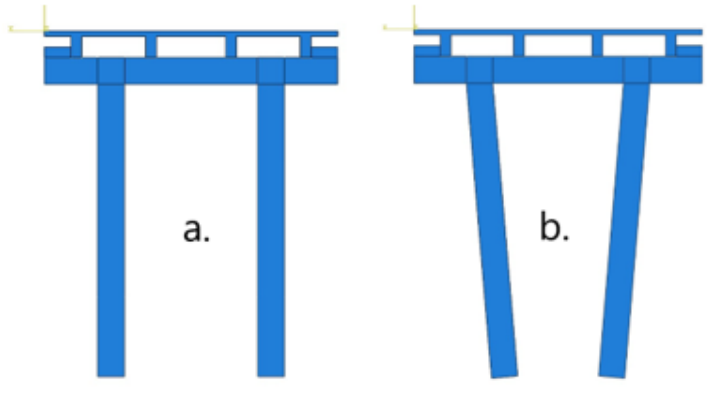
Fig. 6. The angle of columns (a) 0° and (b) 10°.